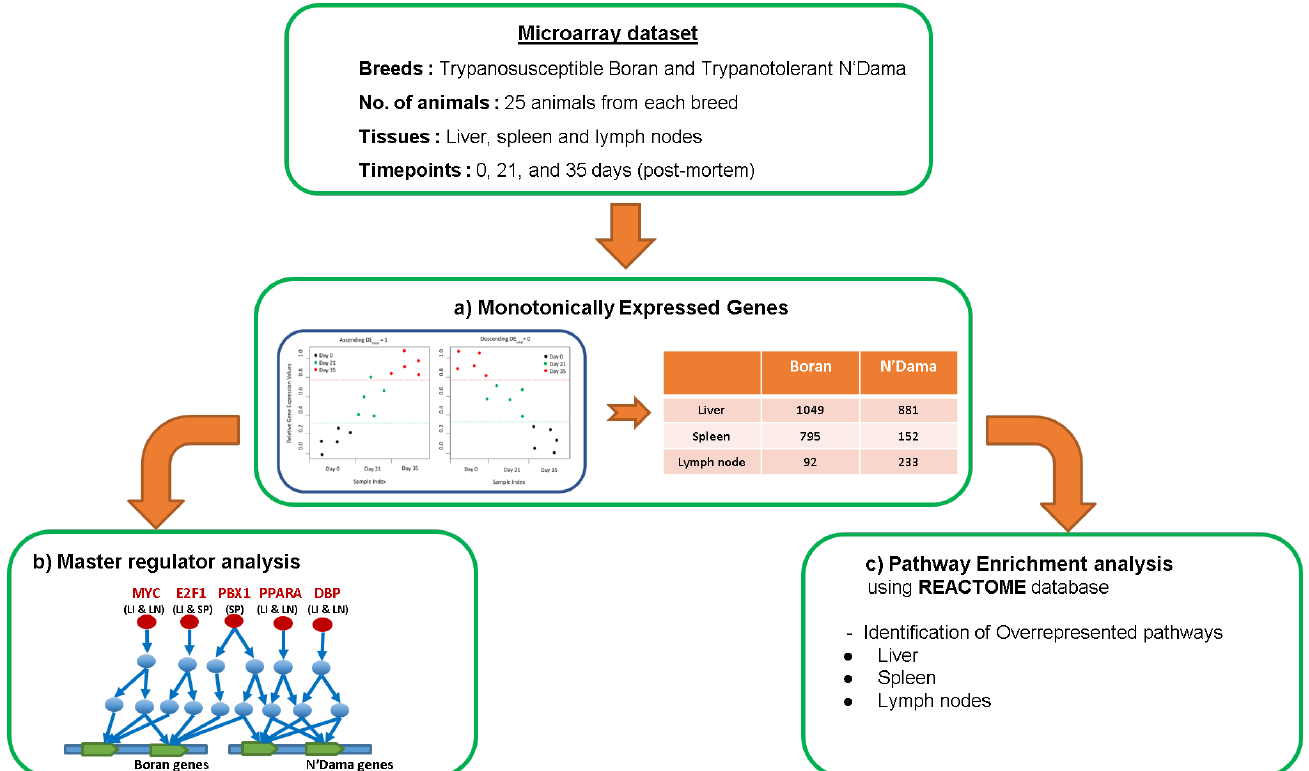
Figure 1. Flowchart of the analysis. ( a ) Monotonically Expressed Genes (MEGs) obtained from the analysis of microarray data set comprising gene expression profiles of two cattle breeds: trypanosusceptible Boran and trypanotolerant N’Dama (Boran Asc - MEGs expressed in the ascending pattern for Boran, Boran Des - MEGs expressed in the descending pattern for Boran, N’Dama Asc - MEGs expressed in the ascending pattern for N’Dama and N’Dama Des - MEGs expressed in the descending pattern for N’Dama; ( b ) Master regulator analysis (Red circles and texts in red represent the exemplarily selected master regulators from this study; LI, SP & LN stand for liver, spleen and lymph node tissues); ( c ) Pathway enrichment analysis performed using Reactome